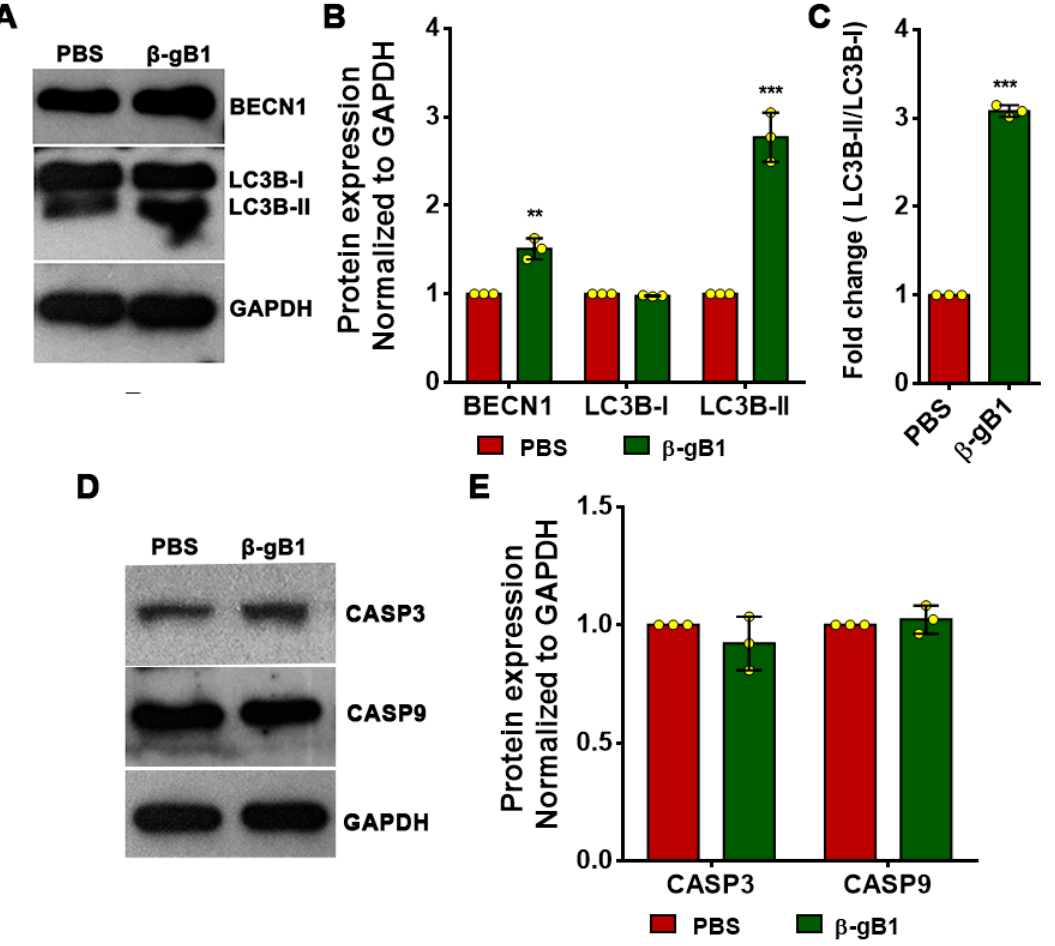
Figure 2. β -ginkgotide-induced autophagy. A . Western blot of BECN1, LC3B-I, and LC3B-II in β -gB1-treated and untreated cells. B . Expression of BECN1, LC3B-I, and LC3B-II compared with the control. C . Ratio of LC3B-II / LC3B-I upon β -gB1 treatment. D . Western blot of caspases CASP3 and CASP9 in β -gB1-treated and untreated cells. E . Expression of caspases CASP3 and CASP9 I compared with the control. Quantification was based on western blot band intensity, and data are shown as mean values. Statistical significance was calculated from biological triplicates (** p < 0.005 and *** p < 0.0005).